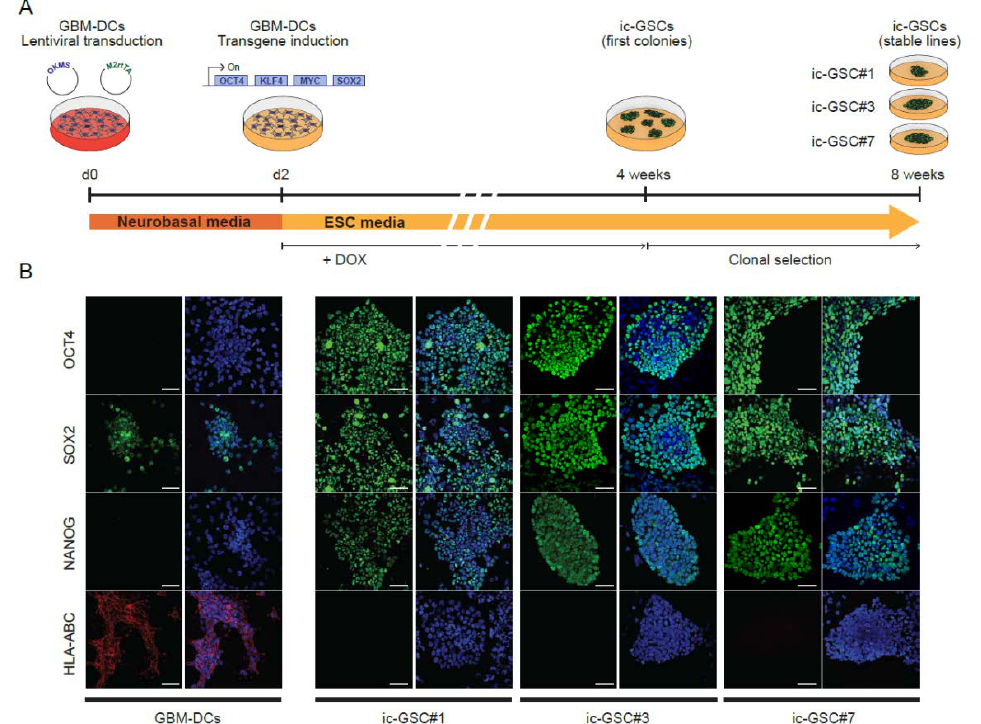
Figure 2. Characterization of an in vitro induced core glioma stem cell model generated from glioblastoma patient-derived cells. ( A ) Workflow depicting the reprogramming of GBM-DCs into ic-GSC stable lines. ( B ) Immunostaining of OCT4, SOX2, NANOG, and HLA-ABC in GBM-DCs and three independent ic-GSC clones: ic-GSC#1, ic-GSC#3, and ic-GSC#7. Scale bars correspond to 50 μm.